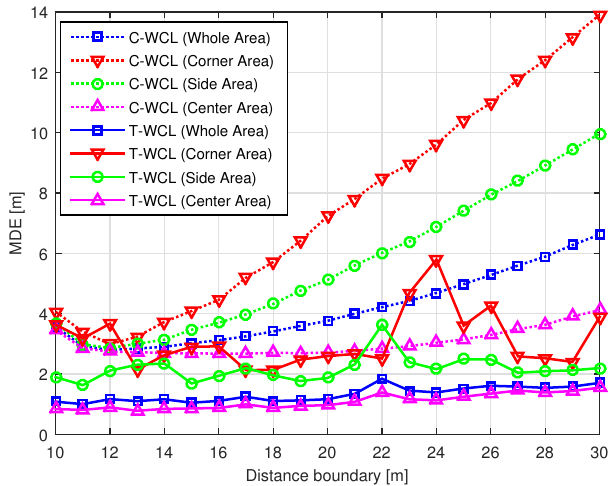
Figure 3. Mean distance error (MDE) performance of each area according to distance